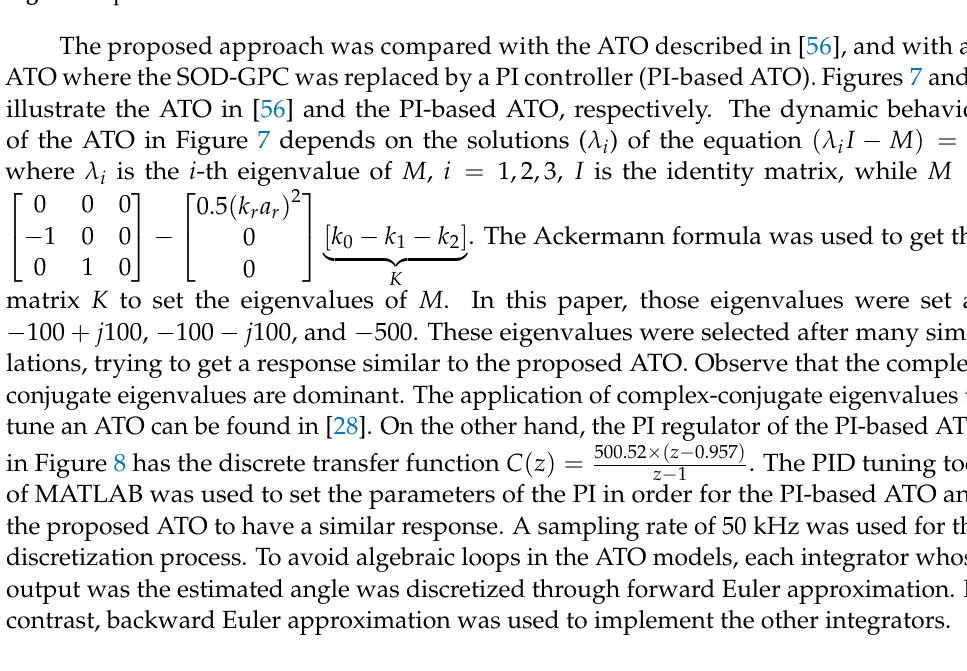
Figure 6. Speed curve used in the tests.